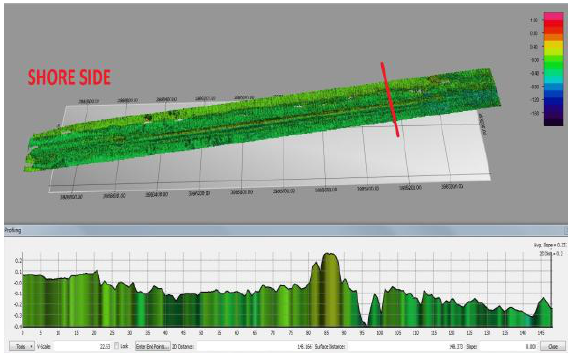
Figure 13: Change detection profile of middle part.